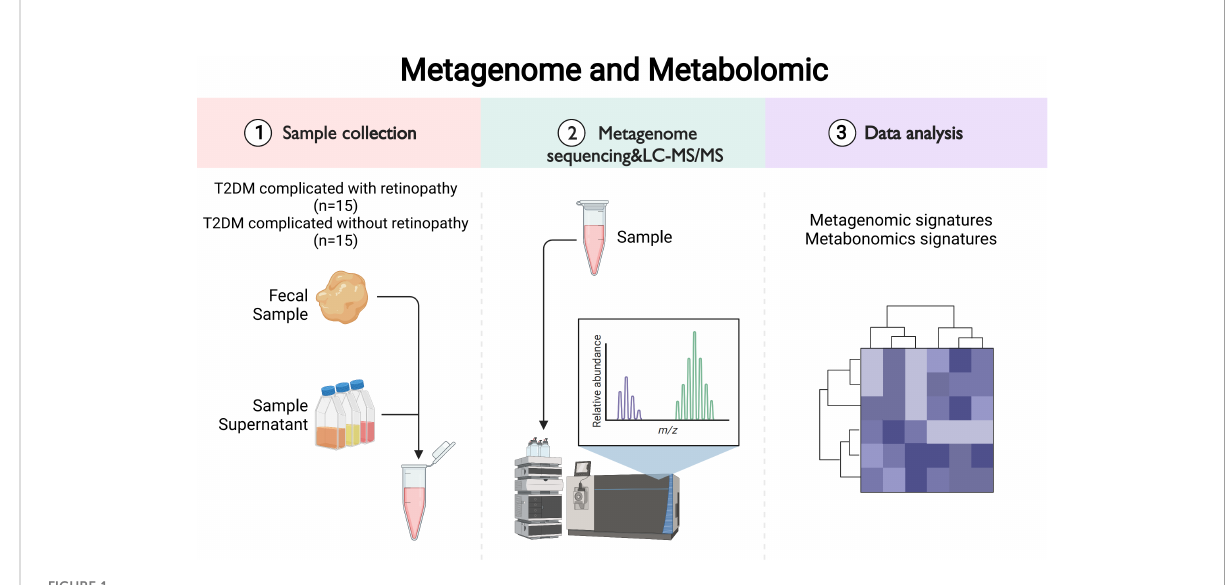
FIGURE 1 The research fl